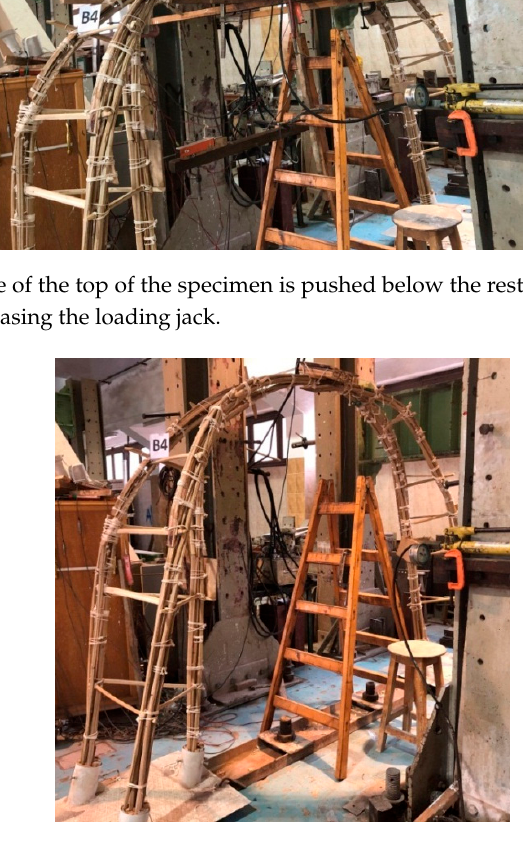
Figure 20. The form of a specimen after releasing the loads and the completion of testing.